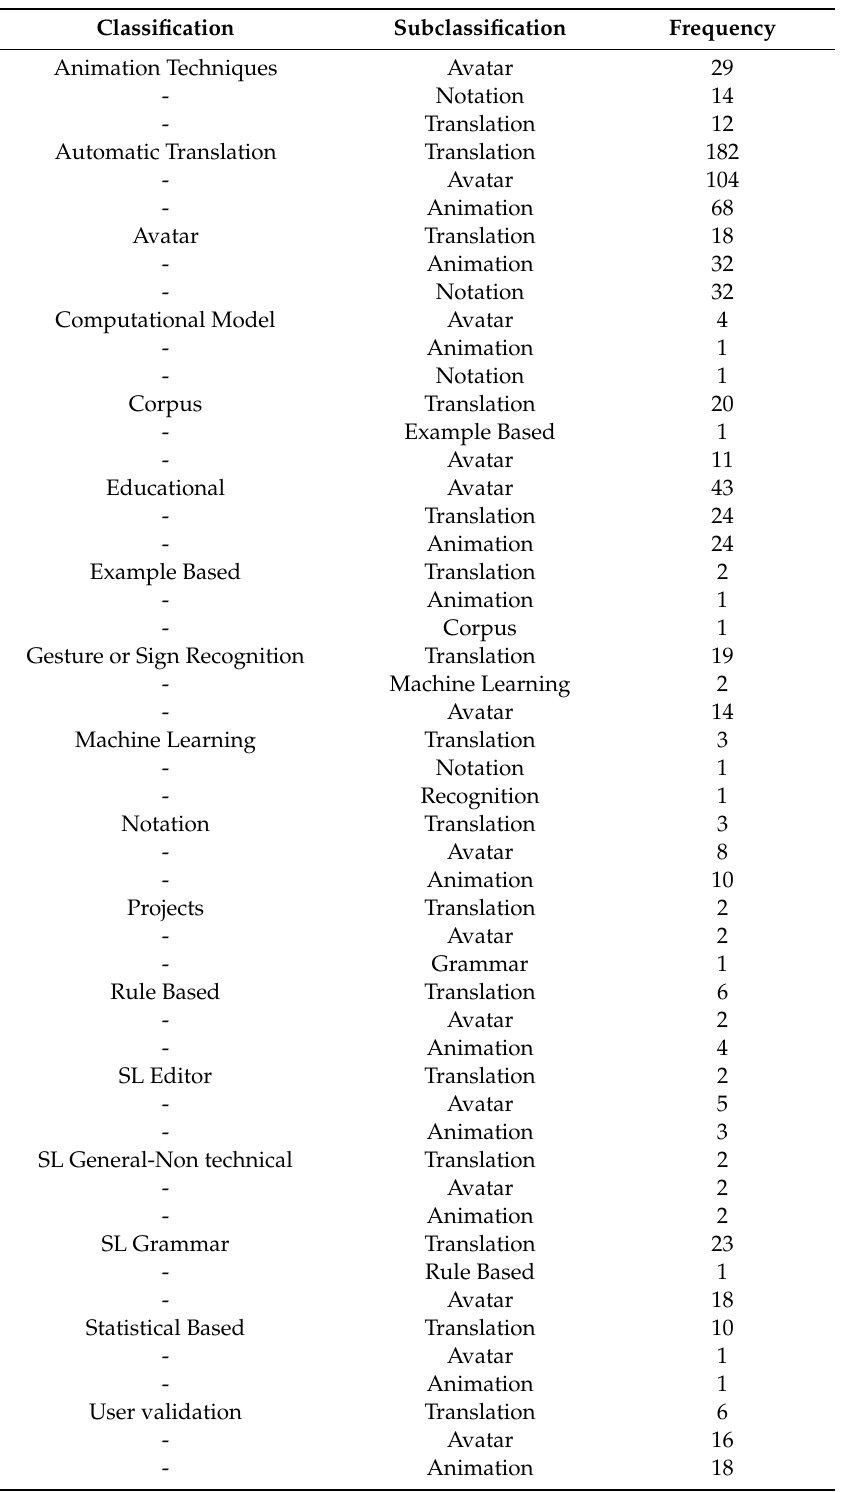
Table 2. Classification–Subclassification top 3 co-occurrence